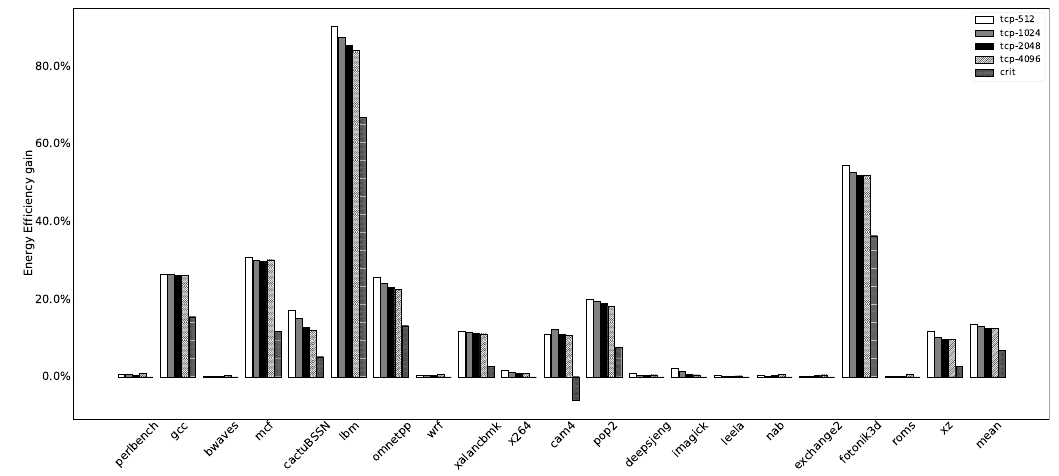
Figure 11. Comparison of different sampling interval lengths.